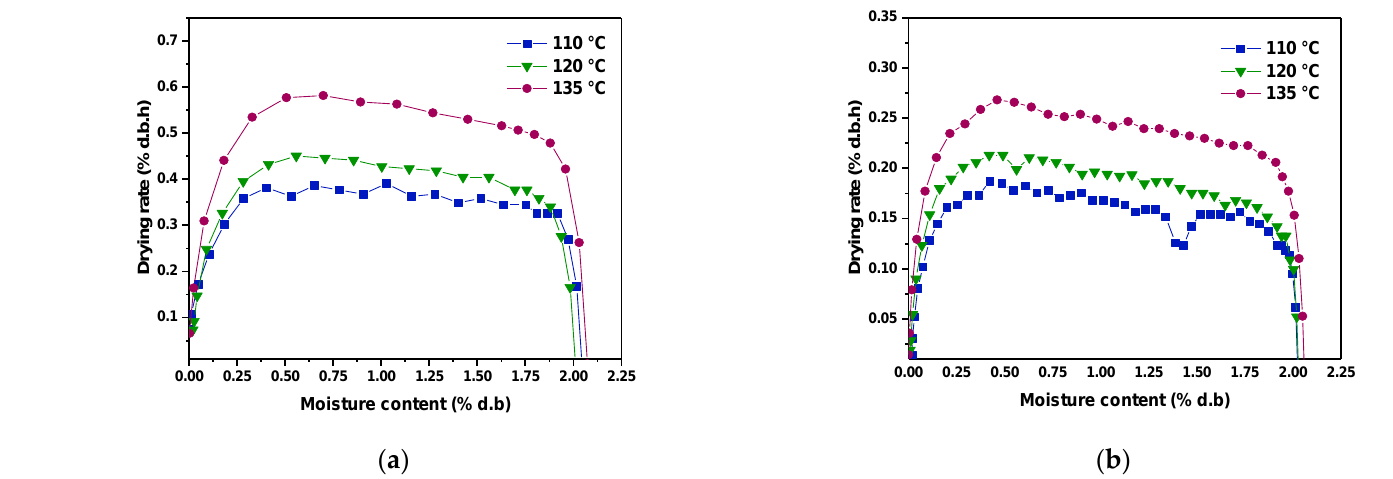
Figure 3. Variation of the moisture content versus time, ( a ): 1 cm and ( b ): 2 cm.